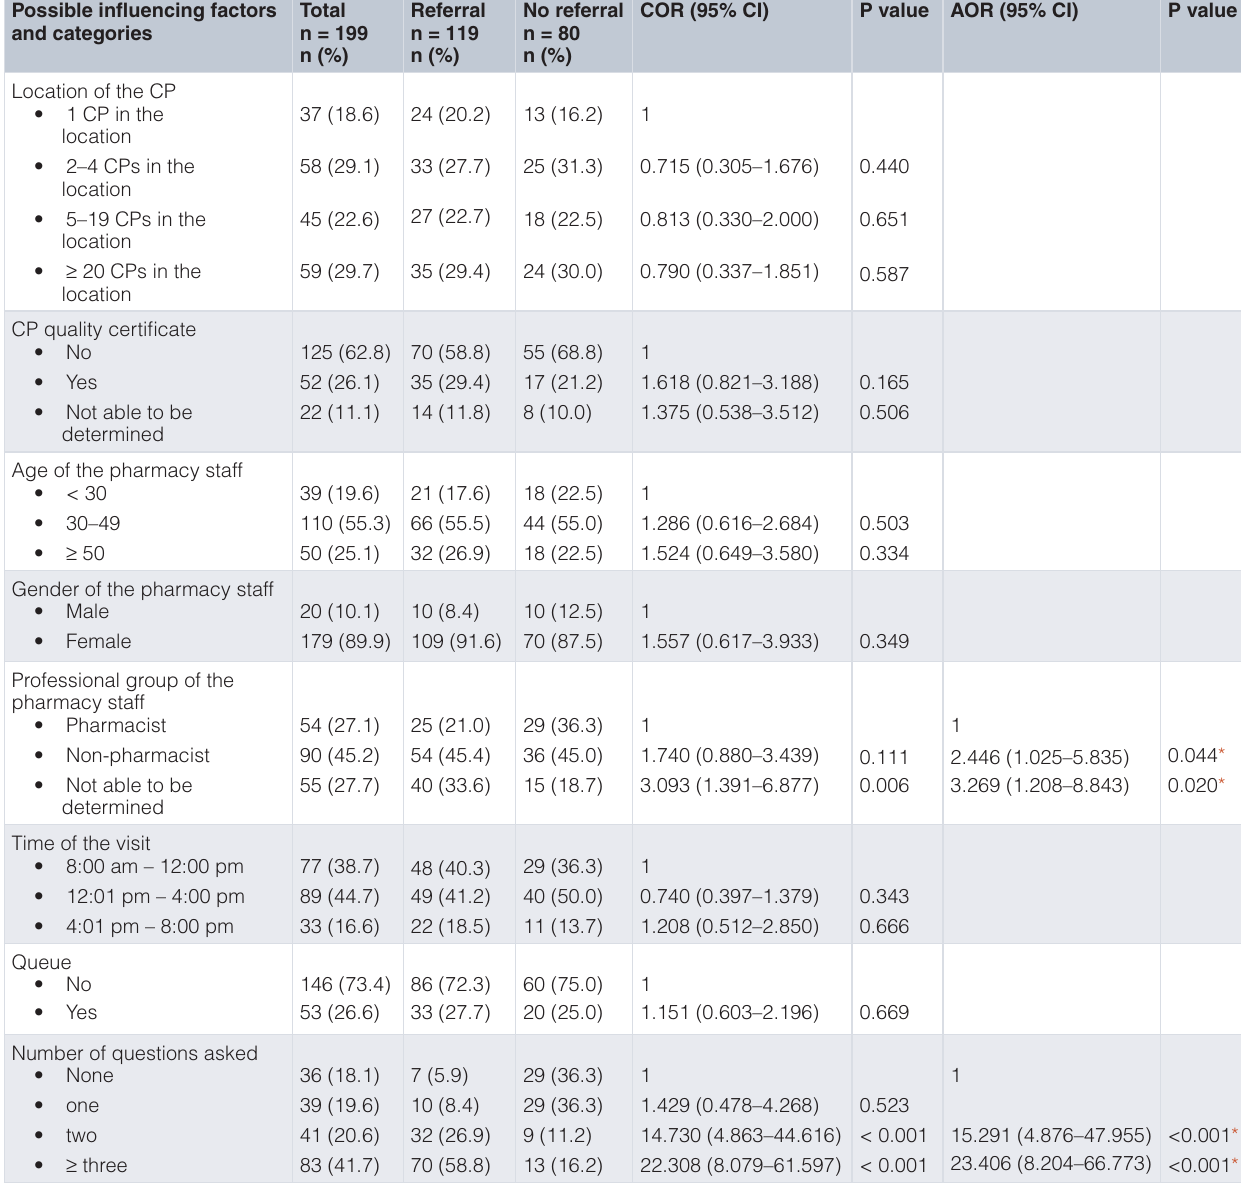
Abbreviations: COR = Crude Odds Ratio; AOR = Adjusted Odds Ratio. * significant at P <